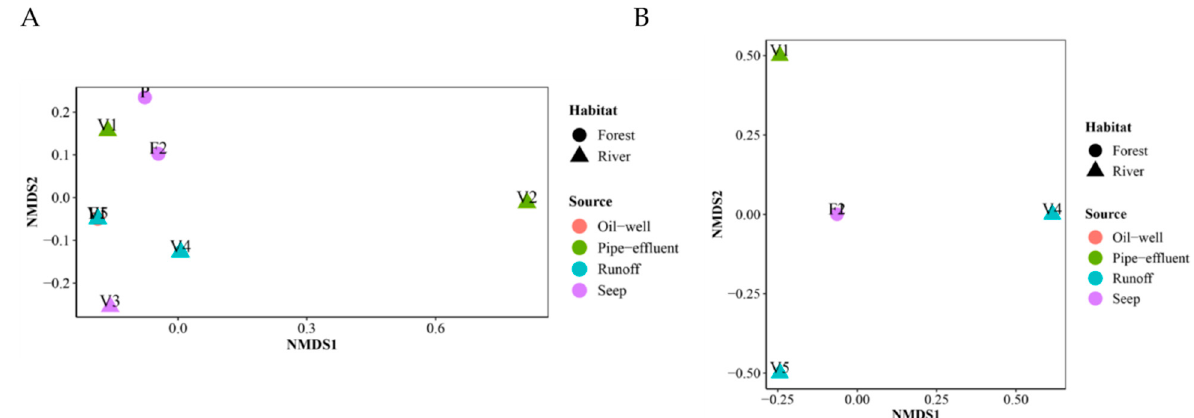
Figure 9. NMDS ordination plots based on the Bray-Curtis distances for environmental factors habitat and source. ( A ) NMDS plot of the filamentous fungal community; note that V5 and F1 are stacked together, where the V5 symbol is a blue triangle and F1 is a red circle. ( B ) NMDS plot of the yeast community; note that F1 and F2 are stacked together, where F1 is a red circle and F2 is a purple circle.